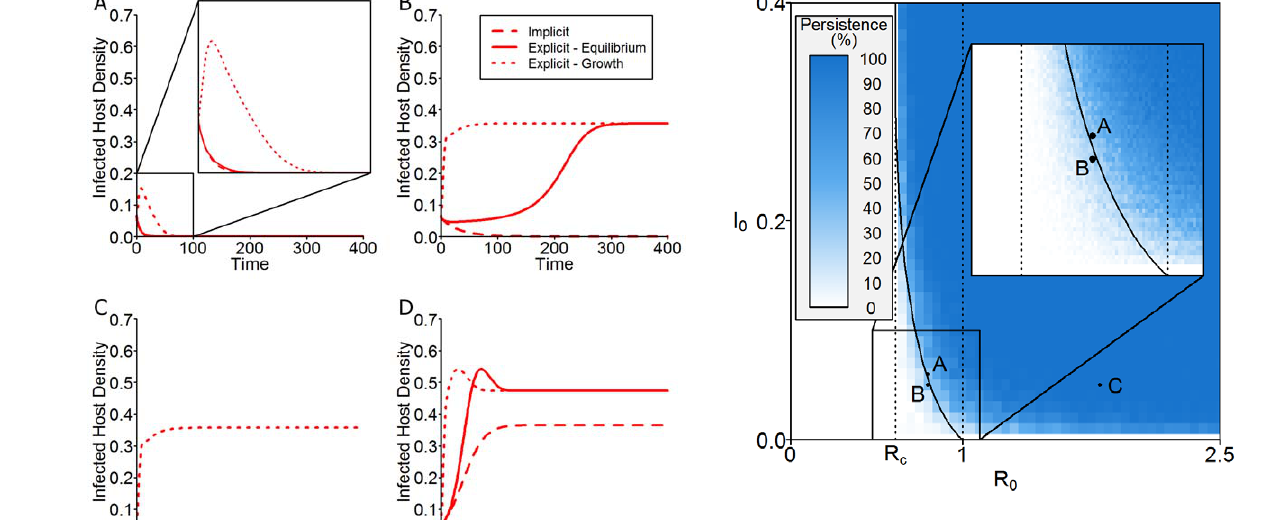
Figure 7. Persistence plot for the stochastic version of the explicit model. For given R 0 and I 0 values, the plot shows the proportion of stochastic simulations that resulted in pathogen invasion and persistence (500 simulations per point). It can be seen that persistence is still determined by I 0 for a range of R 0 values ( R c v R 0 v 1 ) and furthermore that simulations with initial conditions below the deterministic threshold are still able to persist (see inset). Initial conditions for selected numerical simulations are shown. A:( R 0 ~ 0 : 8 , I 0 ~ 0 : 06 ) is just above the deterministic invasion and persistence threshold for the explicit model. B:( R 0 ~ 0 : 8 , I 0 ~ 0 : 05 ) is just below the same threshold. C:( R 0 ~ 1 : 8 , I 0 ~ 0 : 05 ) is significantly above the invasion and persistence thresholds for both models. The default parameter values are given in Table 2.